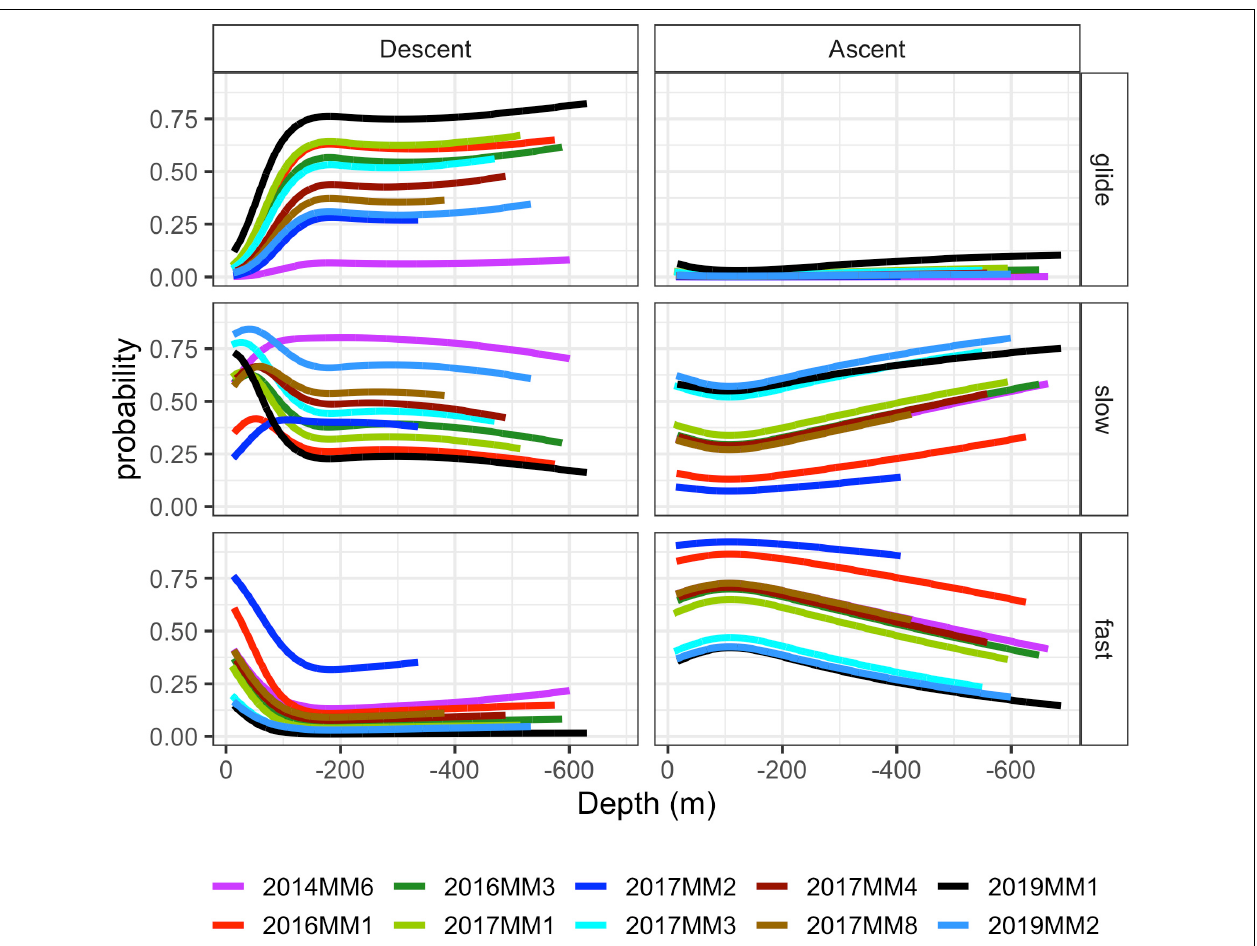
FIGURE 6 | Model outputs for the probability of occurrence of the three stroking modes [glide, slow stroking (slow) and fast stroking (fast)] during ascent and descent in relation to depth (m). Each stroke bout lasted 20 s. The depth range of the model projections reflects the depth range of observations for each individual. Individual 2014MM5 was excluded due to small amount of data ( < 1h).